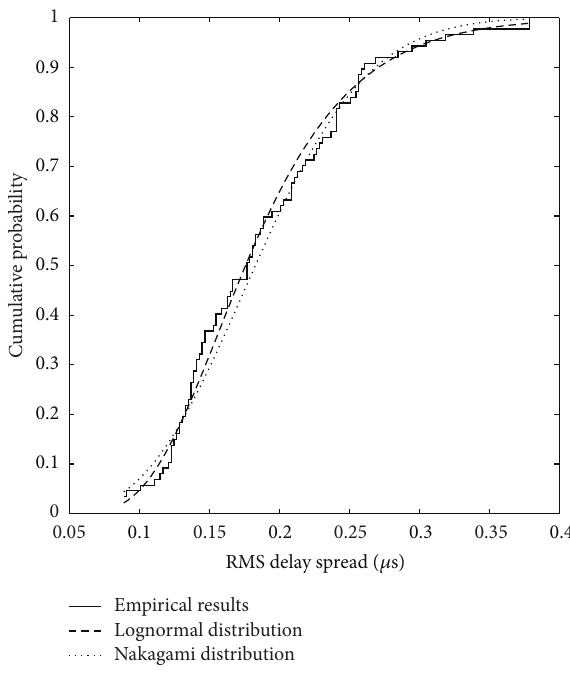
Figure 7: CDF of RMS delay spread for building